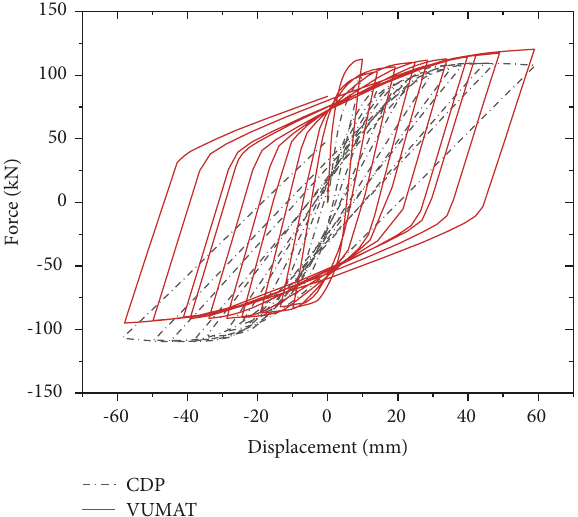
Figure 4: Mesh-dependence.